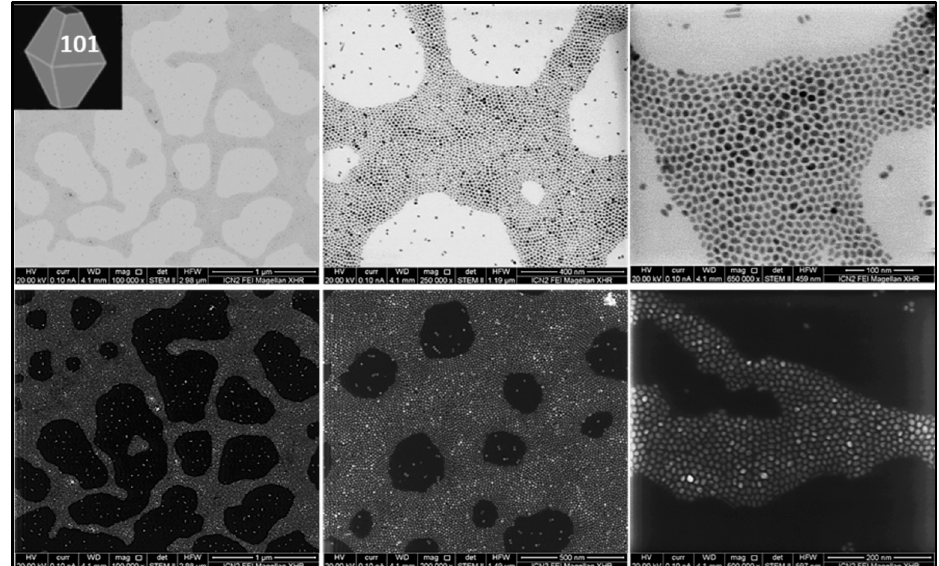
Figure 1. TiO 2 bipyramids. STEM images of TiO 2 NPs synthesized using TiF 4 as a precursor in the presence of OLAM. In the presence of the co-surfactant OLAM, TiF 4 produces highly uniform tetragonal bipyramidal anatase NPs (10 nm side length), which are significantly truncated perpendicular to the [001] direction.